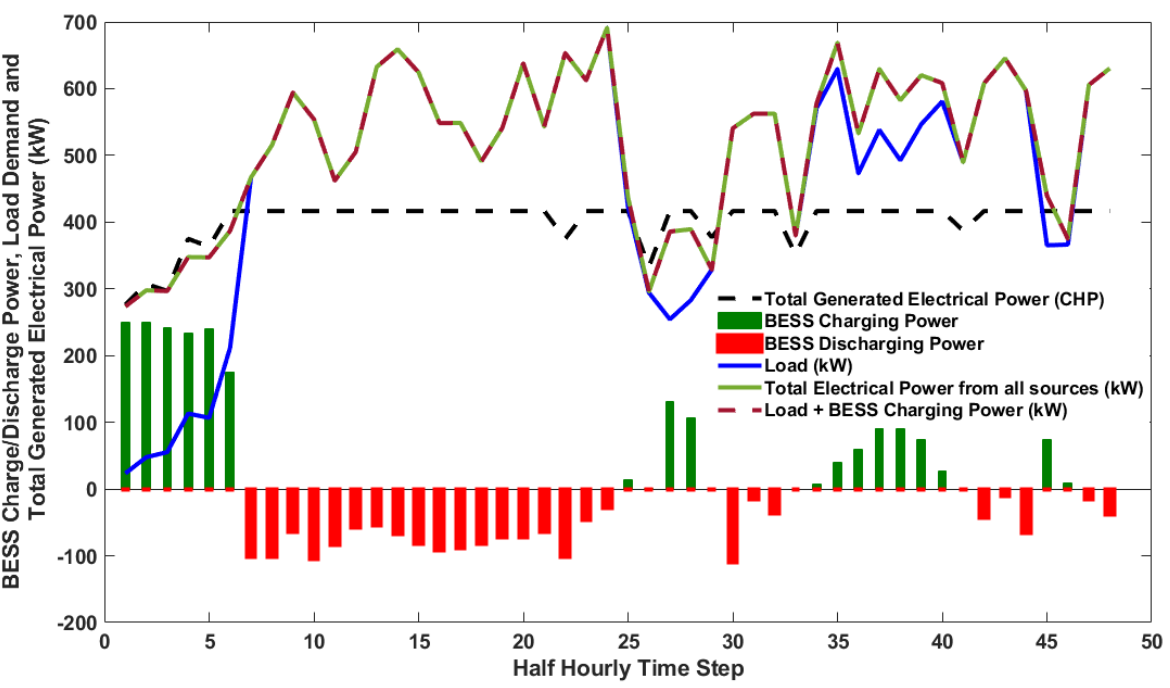
Figure 10. Total electrical power generated, real-time load demand, and BESS charge/discharge command (Scenario 2).